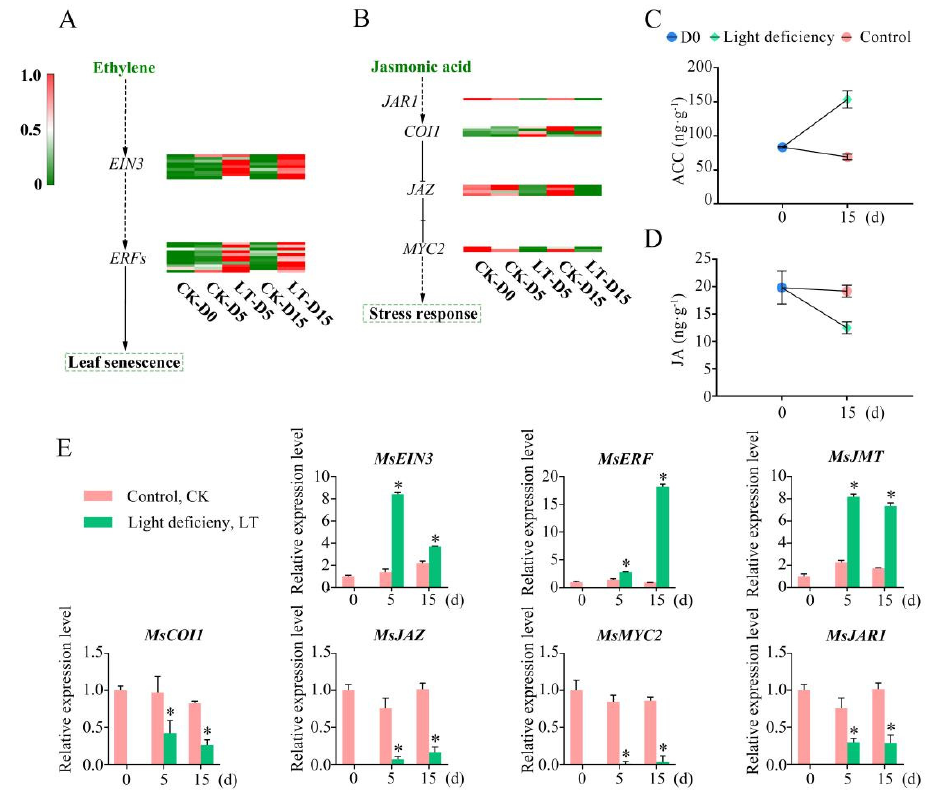
Figure 4. The impact of light deficiency on plant hormone concentration and signaling pathways. ( A ) Heatmap of genes involved in ethylene signal transduction under light deficiency and normal light conditions. ( B ) Heatmaps of genes involved in jasmonic acid signaling under light deficiency and normal light conditions. ( C ) Concentrations of ethylene at d0 and d15 under light deficiency and normal light conditions. ( D ) Concentrations of jasmonic acid at d0 and d15 under light deficiency and normal light conditions. ( E ) qRT-PCR analysis of key genes involved in plant hormone signaling under light deficiency and control conditions for 0 d, 5 d, and 15 d. Data are the means of three biological replicates and three technical replicates. The 2 − ∆∆ ct method was employed to conduct the gene differential expression analysis. * indicates significant differences in comparison with the control groups corresponding to time points at p < 0.05.